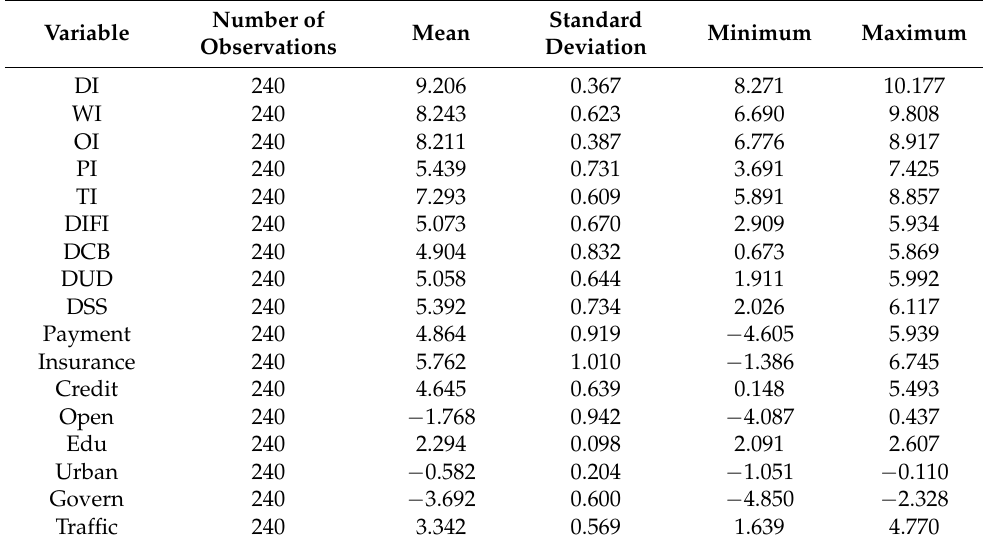
Table 1. Descriptive statistics of